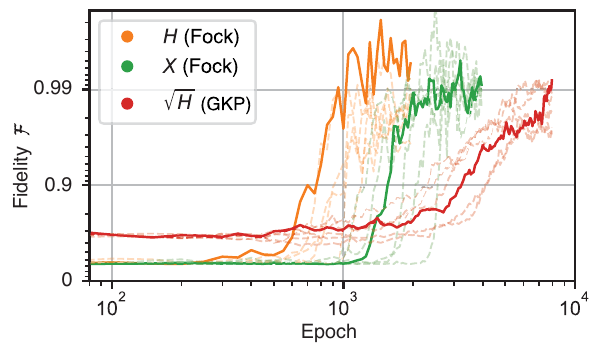
FIG. 10. Learning gates for logical qubits encoded in an oscillator. The agent is trained to produce Hadamard H and Pauli X gates on the Fock qubit, and a non-Clifford the GKP qubit. The average gate fidelity is used as an evaluation metric. The background trajectories correspond to six random seeds for each gate, and solid lines show the trajectory with the highest final